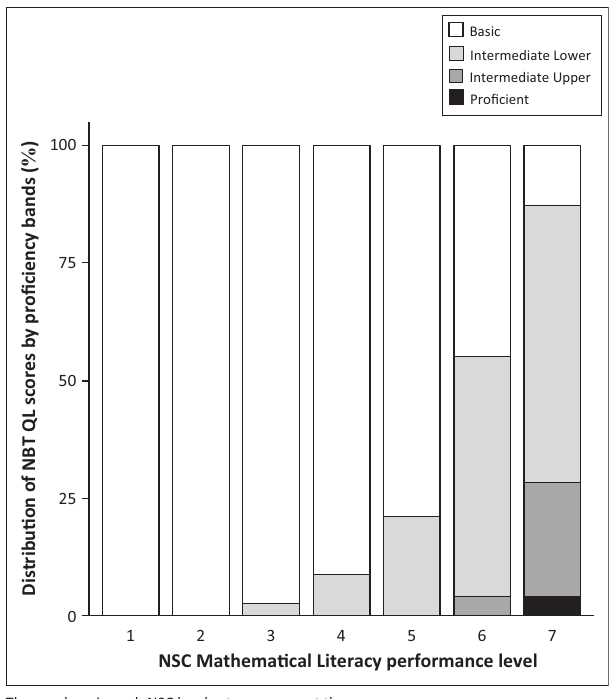
FIGURE 7: Percentage distribution of National Benchmark Test quantitative literacy scores by proficiency band for different National Senior Certificate Mathematical Literacy levels achieved.